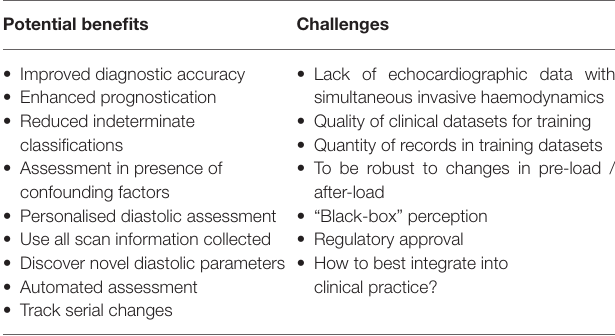
TABLE 2 | Challenges and potential benefits of machine-learning augmented echocardiography for diastolic analysis. Machine-Learning Augmented Echocardiography for Diastolic